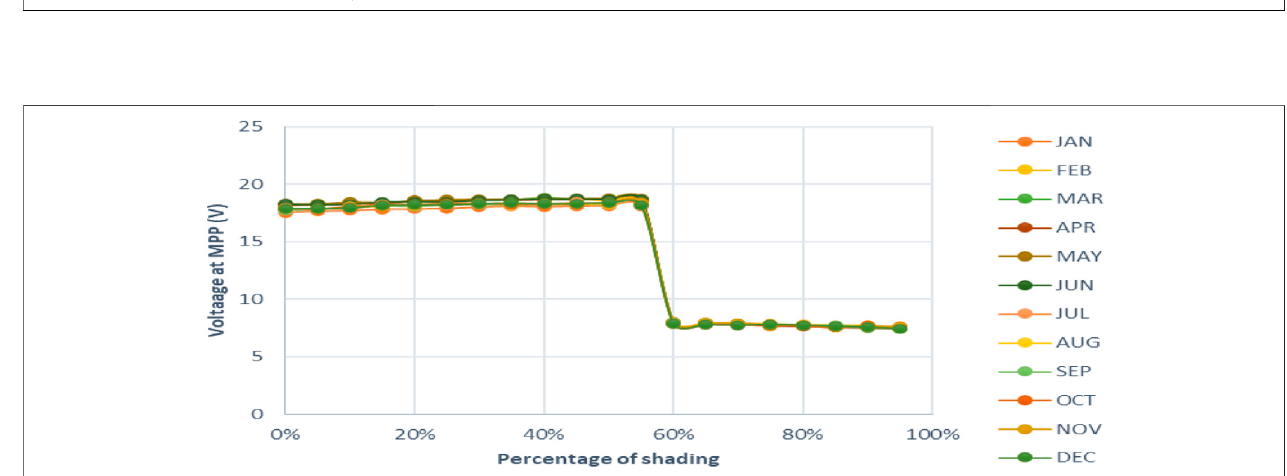
FIGURE 6 | Monthly evolution curve of I mp according to the shading.